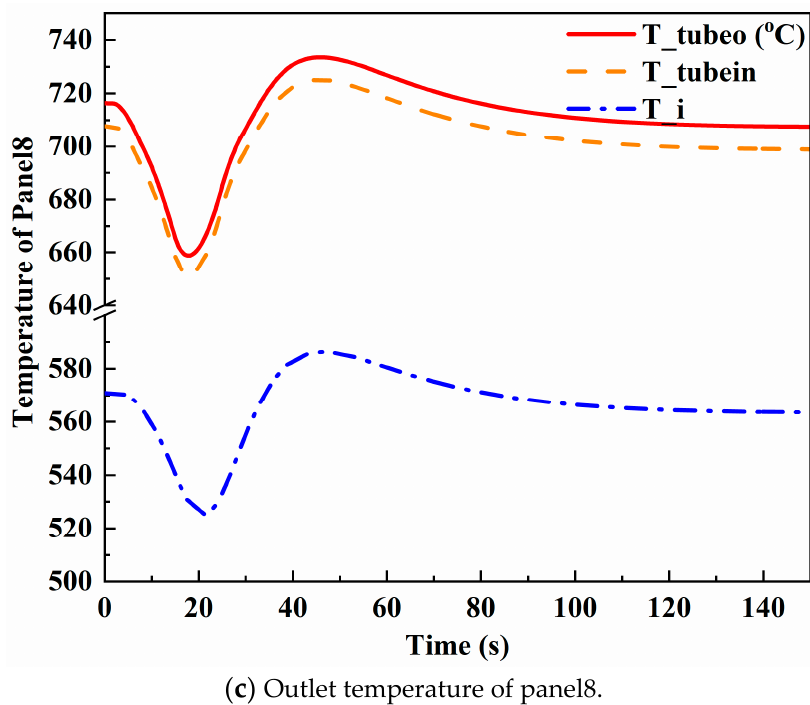
( c ) Outlet temperature of panel8. Figure 6. Influence of reciprocating DNI disturbance (800–600–800 W/m 2 ). Figure 6. Influence of reciprocating DNI disturbance (800–600–800 W/m 2